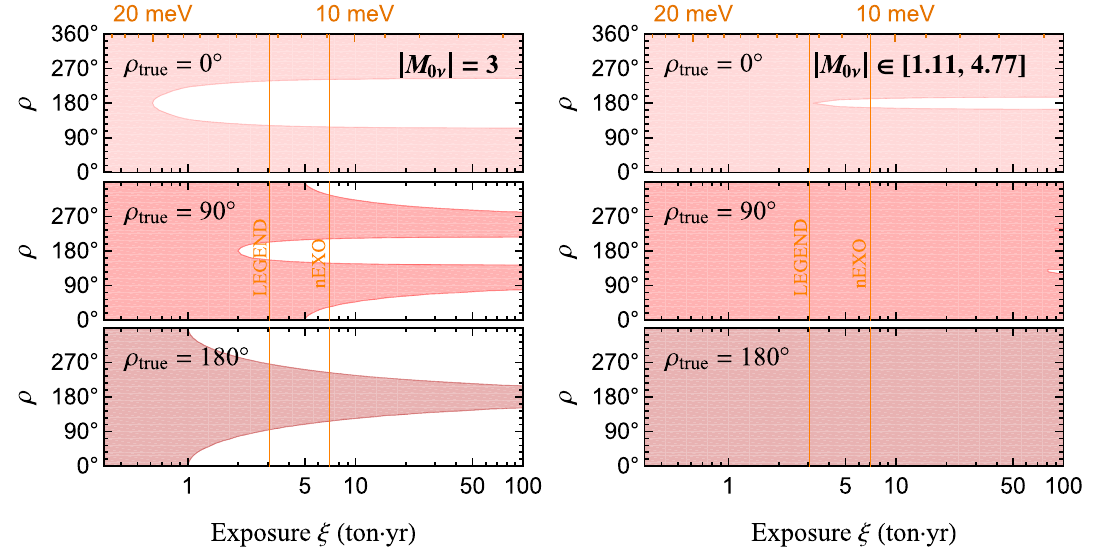
Fig. 5 The 3 σ sensitivities to the Majorana CP phase ρ with respect to the 136 Xe exposure ξ , by assuming the NME to be completely known as (cid:2) (cid:2) (cid:2) M (cid:2) = 3 (left panel), or spreading over a range 0 ν (right panel), during the fit. All the cases assume a positive signal of